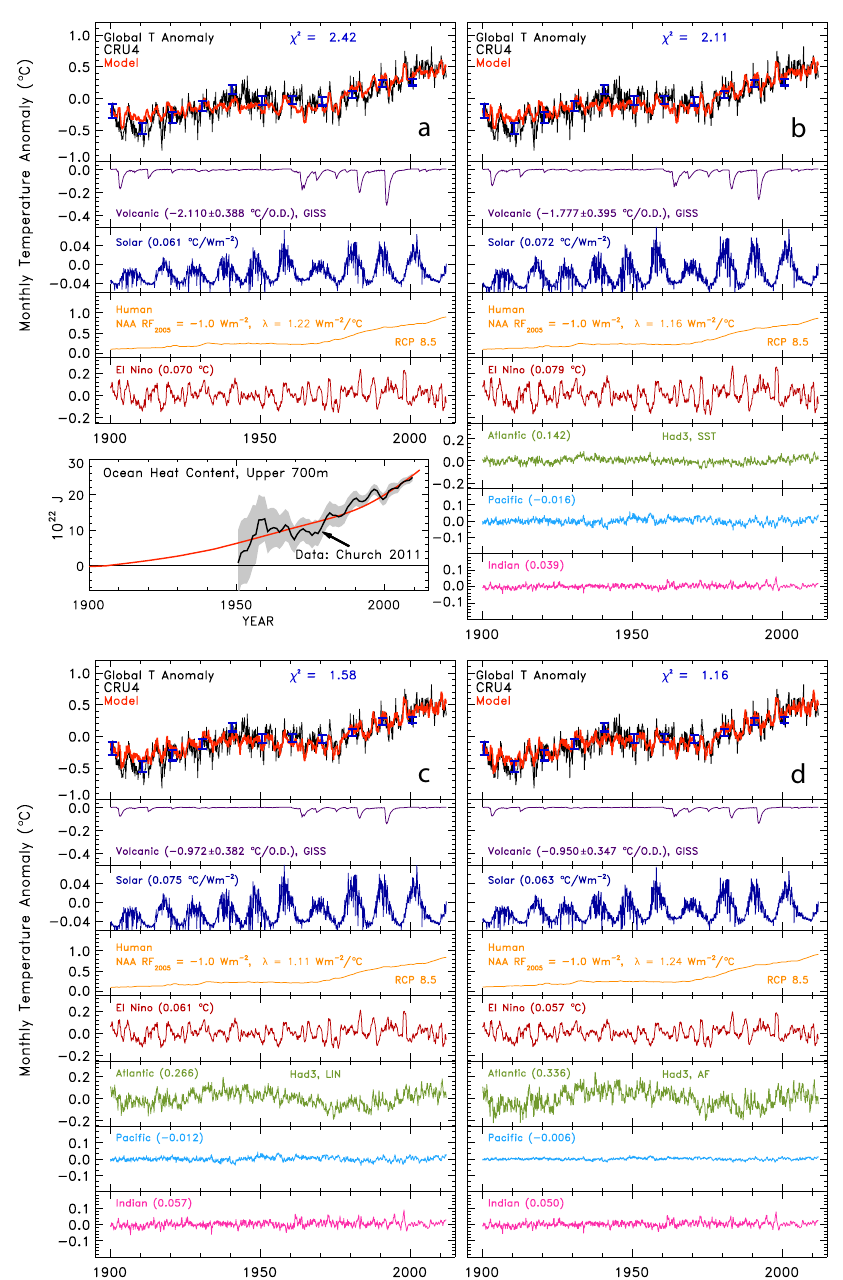
Fig. 6. Ladder plots showing the MLR simulation of the global temperature anomaly from CRU4. The top rung of each of the four ladder plots compares measured (black) and modelled (red) 1T , from the start of 1900 to the end of 2010. Values of χ 2 are given and 1-sigma uncertainty of 1T , available for every month, is shown periodically (blue error bars). The other rungs show contributions to 1T from volcanoes (based on SOD), solar (based on TSI), humans (sum of GHG RF and NAA RF terms in Eq. (2)), and the various ocean terms (see text). Values of the regression coefficients are given; for the volcanic coefficient, the statistical uncertainty from the regression is also presented. Specified values of NAA RF 2005 and output values of the sensitivity parameter are given in the rung labelled Human. (a) (Top) Results of MLR for a simulation where the regression coefficients for AMV, PDO and IOD have been set to zero. (Bottom) Modelled and measured ocean heat content of the upper 700m of the world’s oceans. Data are from Church et al. (2011) except 9 . 5 × 10 22 J has been added to the measurements at all times so that the mean value of OHC of our model matches the mean measured value of OHC for the time period of observation (measurement is an anomaly so this type of adjustment is valid). The red line is the modelled value of 0.7 × Q OCEAN × 3 . 3 × 10 14 m 2 × 1t , where 1t is the time evolved since the start of 1900. (b) Same as top part of (a) but also including rungs showing contribution to the regression from variations in SST within the Atlantic (based on AMV Had3 SST ), Pacific (PDO) and Indian (IOD) Oceans. (c) Same as (b) but for AMV Had3 LIN . (d) Same as (b) but for AMV Had3 AF